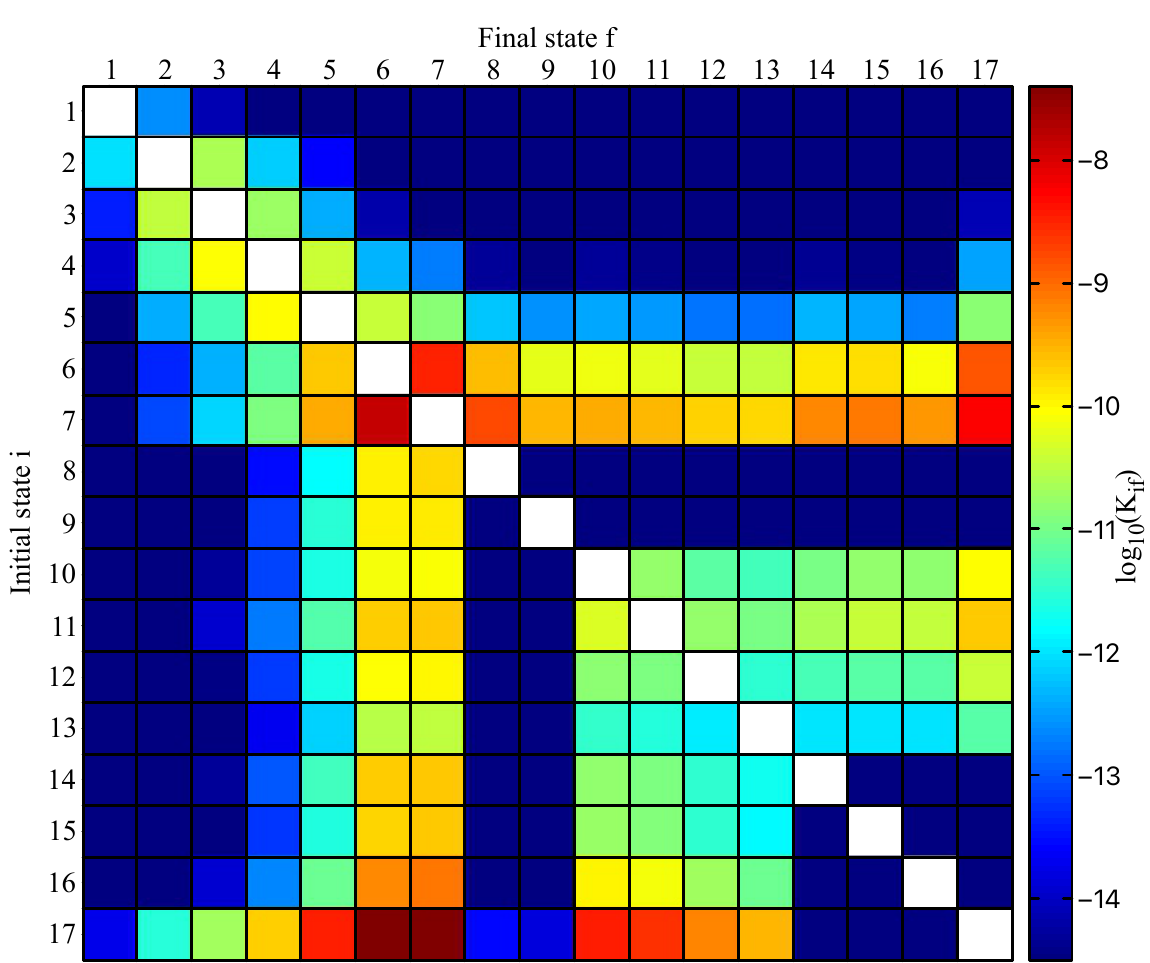
(cid:0) 1,3 (cid:1) + L